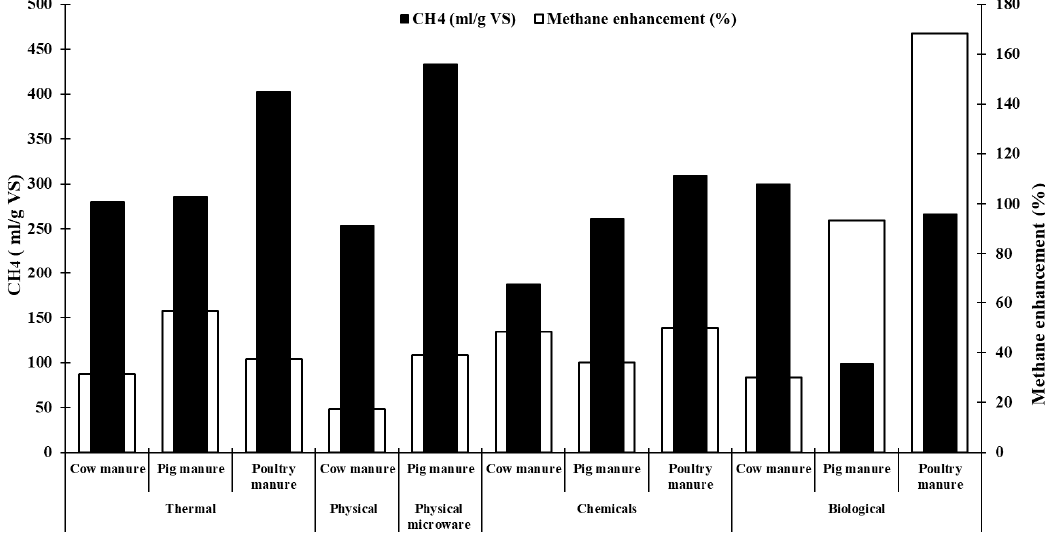
Figure 2. Methane production from cow, pig and poultry manure with respect to physical, chemical, thermal and biological pretreatments.